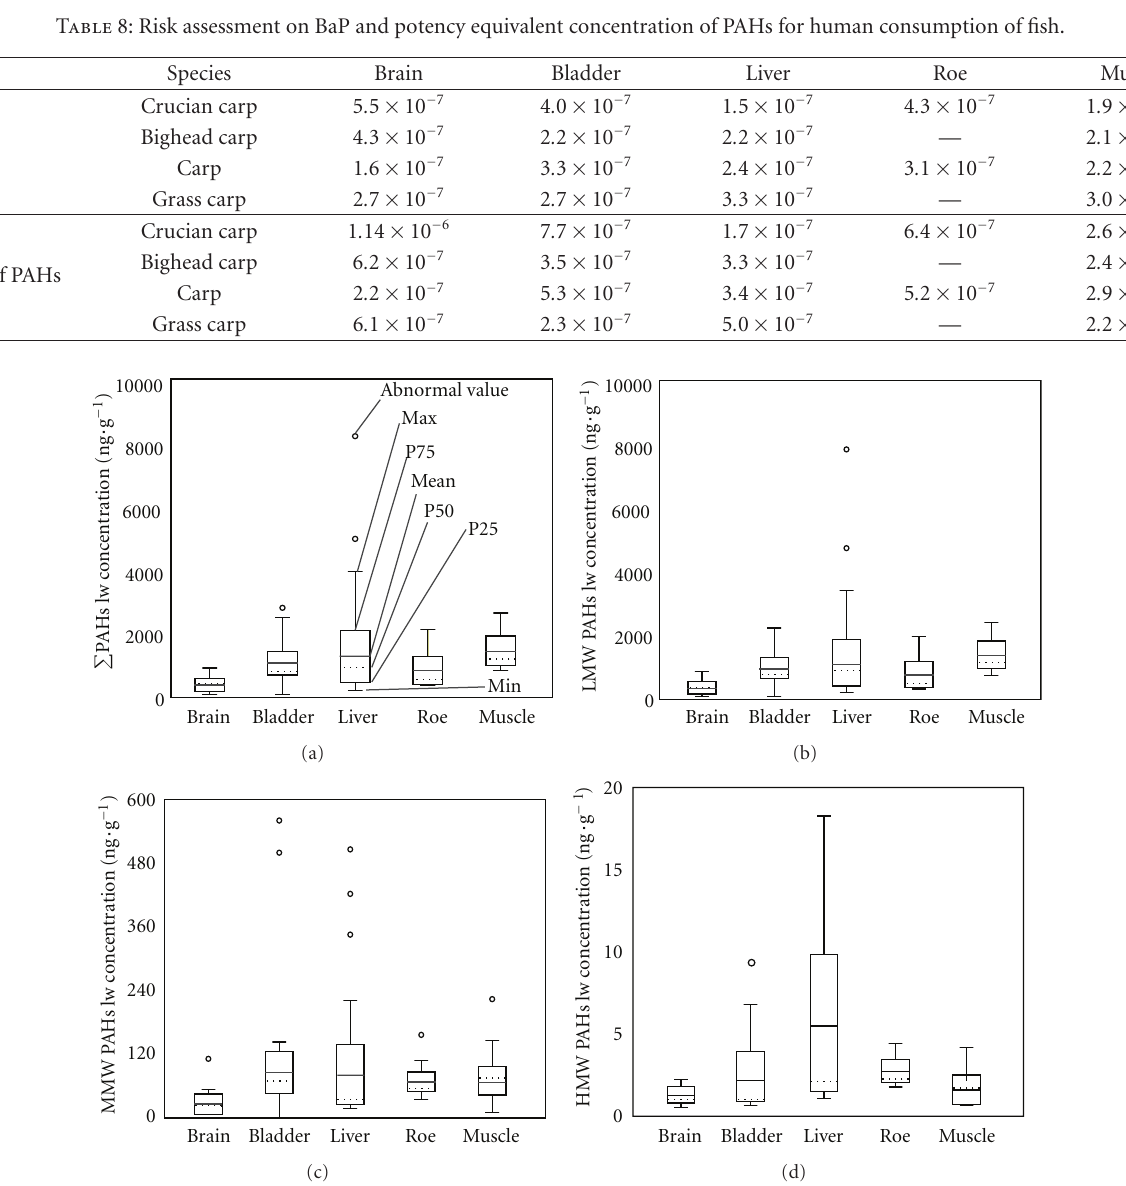
Figure 6: Lipid-normalized contents of (a) total PAHs (PAH16), (b) LMW-PAHs, (c) MMW-PAHs, and (d) HMW-PAHs in four fish tissues.